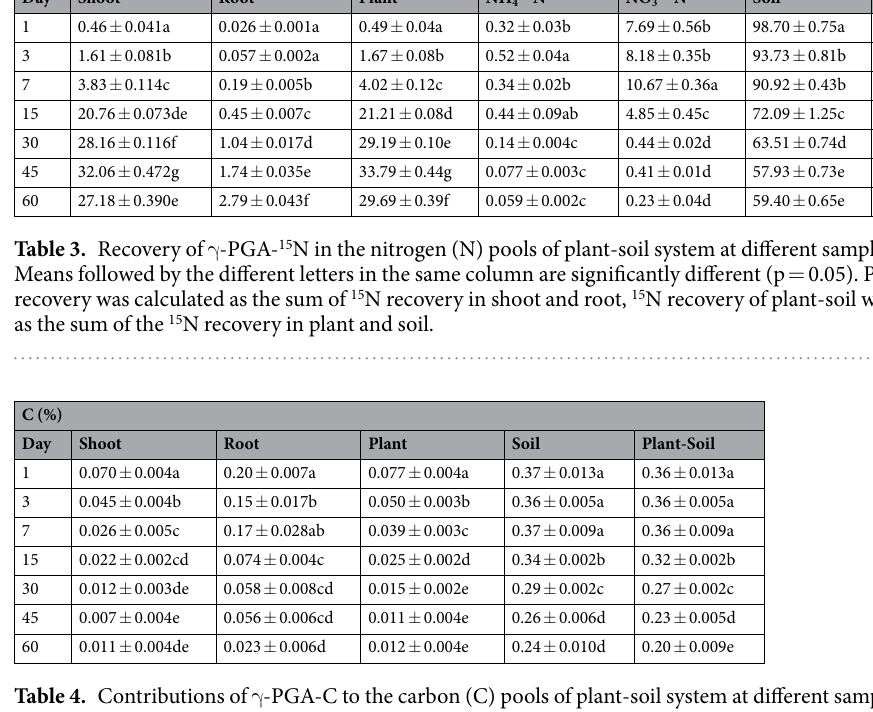
Table 4. Contributions of γ -PGA-C to the carbon (C) pools of plant-soil system at different sampling days. Means followed by the different letters in the same column are significantly different (p = 0.05); Contribution of γ -PGA-C to the C pool in plant-soil system was calculated as the percentage of the recovered γ -PGA-C to the total C in each C pool.